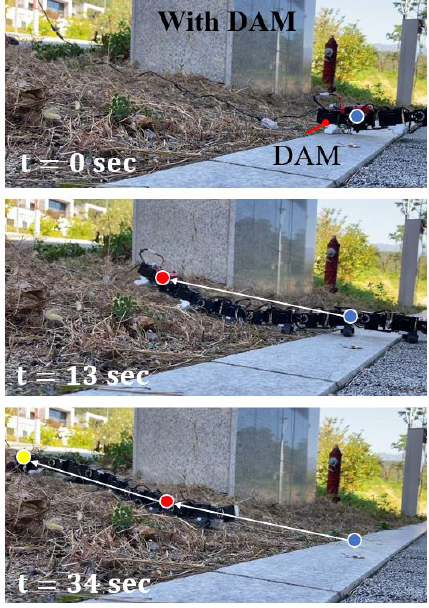
Appl. Sci. 2020 , 10 , x FOR PEER REVIEW Figure 20. Performance of the ascending motion without the DAM. Figure 20. Performance of the ascending motion without the DAM.